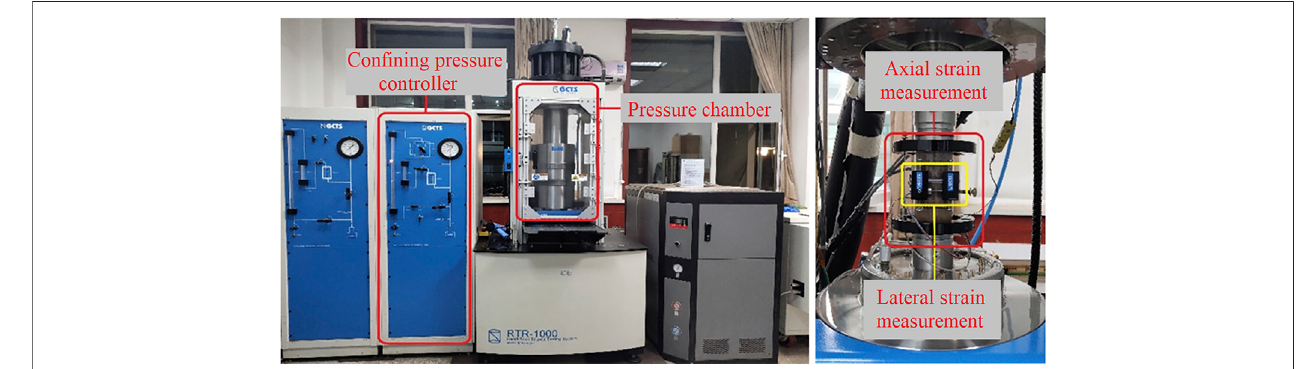
FIGURE 4 | Test devices.